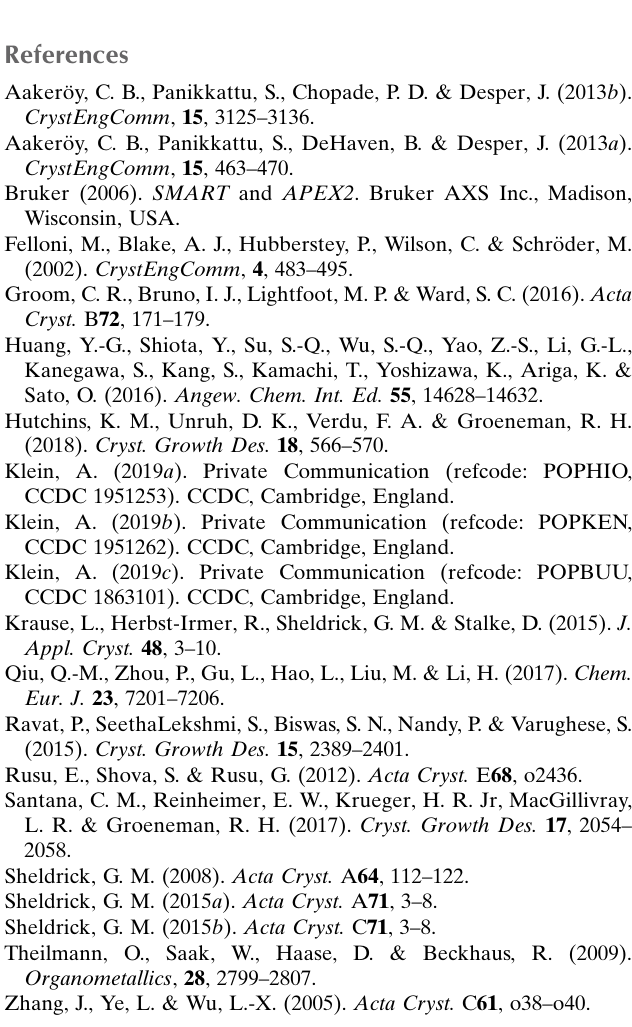
Table 2 Experimental details. Crystal data Chemical